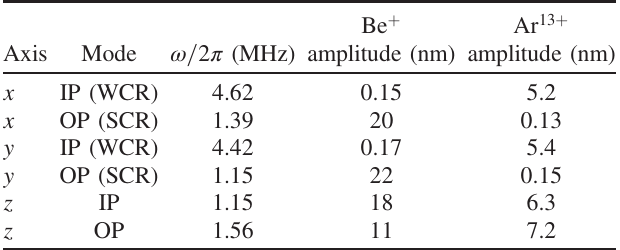
TABLE II. Calculated frequencies of the axial ( z ) and radial ( x , y ) normal modes for the two ions in a Be þ -Ar 13 þ Coulomb crystal under our approximate experimental trapping conditions, along with the extents of the ground-state wave functions for the individual ions in these modes. IP and OP refer to in- and out-of- phase motion, respectively, and SCR and WCR refer to the strongly coupled and weakly coupled radial modes, respectively. The Be þ ion has a much smaller motional amplitude in the x and y IP modes, leading to greatly inhibited laser cooling of these